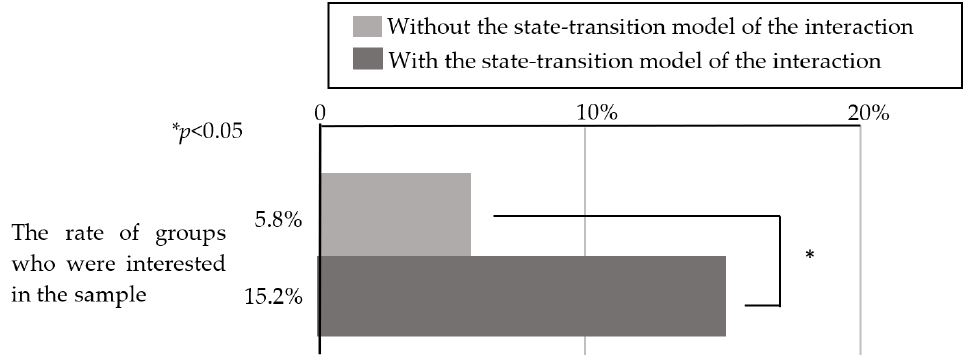
Figure 17. Percentage of customers who were interested in the sample.